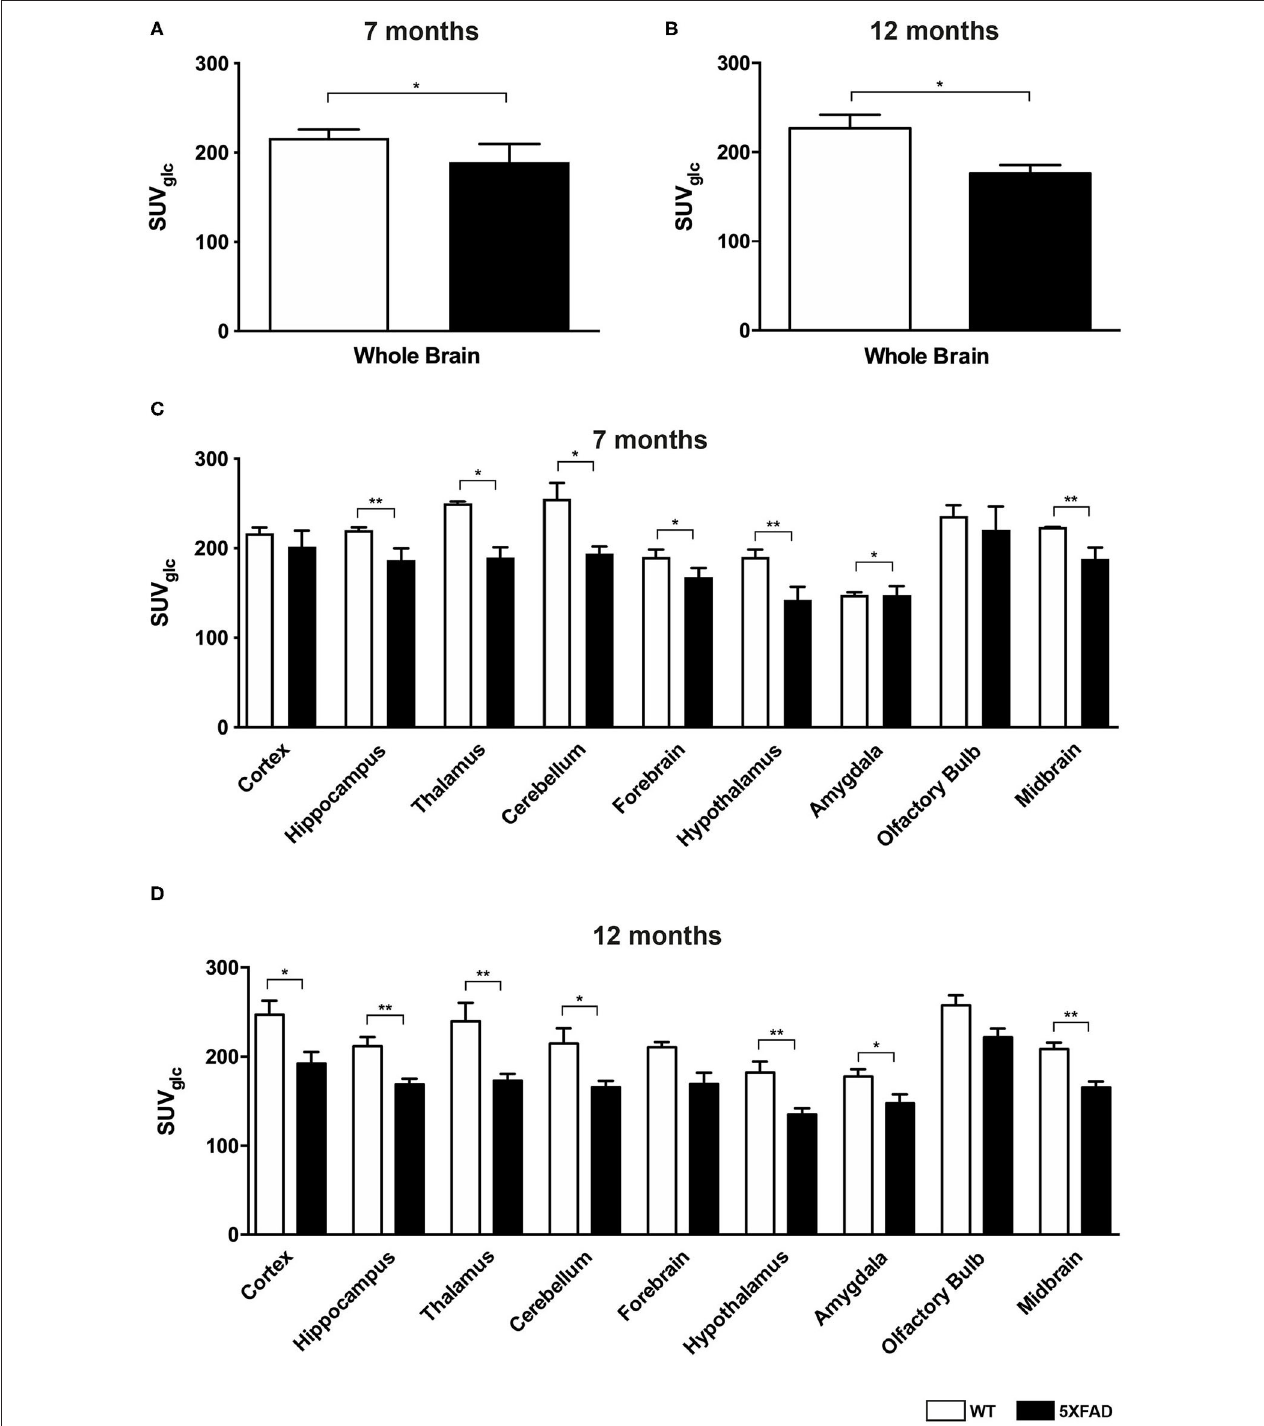
FIGURE 1 | 18 F-FDG uptake in 7- and 12-month-old WT and 5XFAD mice. (A) 7-month-old 5XFAD mice showed a significantly lower SUVglc in the whole brain compared to age-matched WT mice. (B) 12-month-old 5XFAD mice showed a significantly lower SUVglc in the whole brain compared to age-matched WT mice. (C) 7-month-old 5XFAD mice showed a significantly lower SUVglc in all brain regions except for cortex and olfactory bulb compared to age-matched WT mice. (D) 12-month-old 5XFAD mice showed a significantly lower SUVglc in all brain regions compared to age-matched WT mice except for forebrain and olfactory bulb. Unpaired t -test; * p < 0.05; ** p < 0.01; data presented as mean + /- SEM.